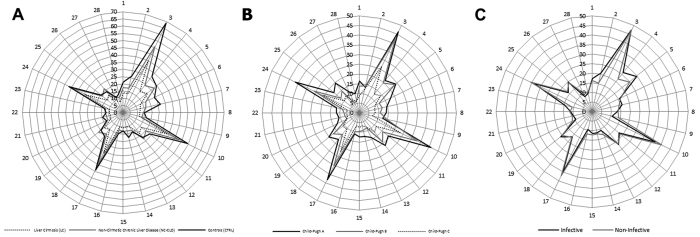
Comparison of BPs relative to patients with LC and NC-CLD and CTRL (Panel A), cirrhotic patients with different CPC (Panel B) and patients with infective and non-infective CLD (Panel C).The radar-plots (see description in the text) reveal a progressive concordant reduction of mean responses from CTRL and NC-CLD to LC patients and, among LC patients, for increasing CPC. Concerning discrimination between infective and non-infective aetiology, major reductions of mean responses have been observed in sensors 2, 4 and 5 at 50 °C for patients with non-infective liver disease.